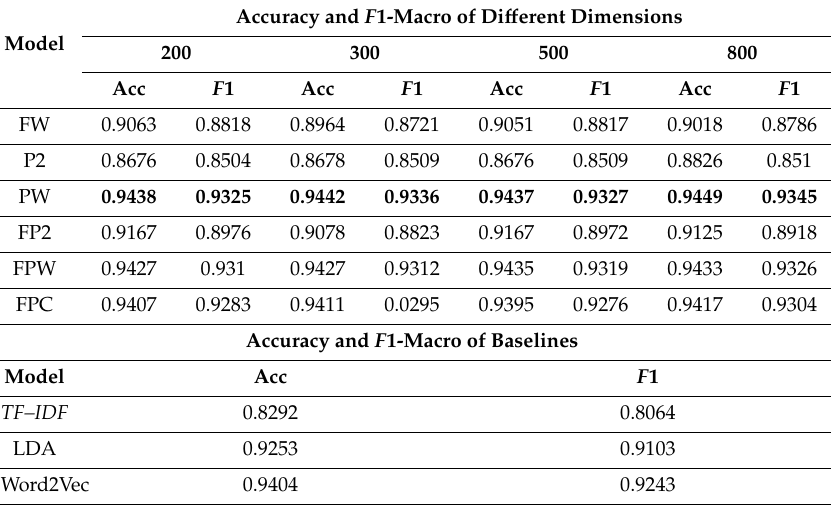
Table 3. Results of Amazon_6 in four classes for 5705 texts by